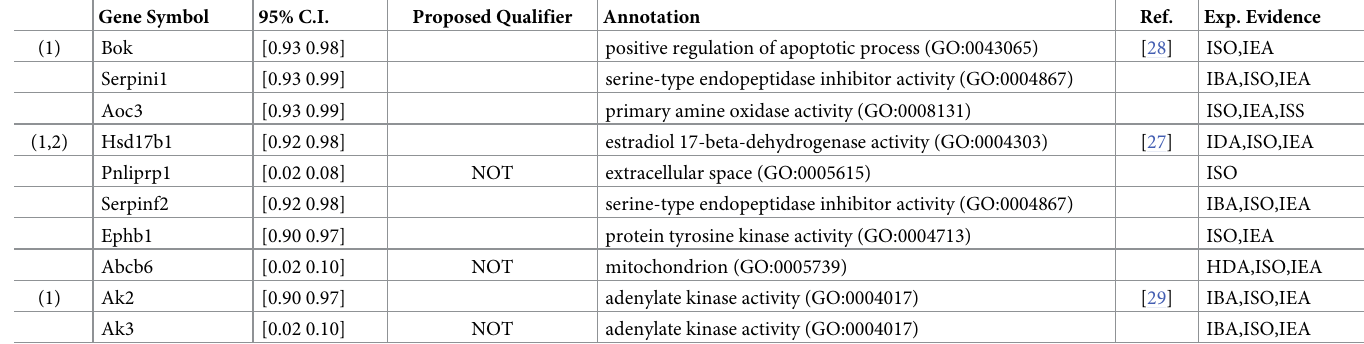
Table 7. List of proposed annotations for mouse proteins. The 95% CI corresponds to the posterior probability of the model. We suggest that values with the CI close to zero indicate absence of function and should be annotated with the qualifier “NOT”. The Ref. column lists literature in which we found evidence of the corresponding annotation can be found, and the last column lists evidence codes found for annotations to the same term in the GO database (note that all corresponding GO database annotations are presence of function). Notes : (1) Exp. evidence found in literature. (2) Was not present in our training dataset, but we correctly predicted an experimentally supported